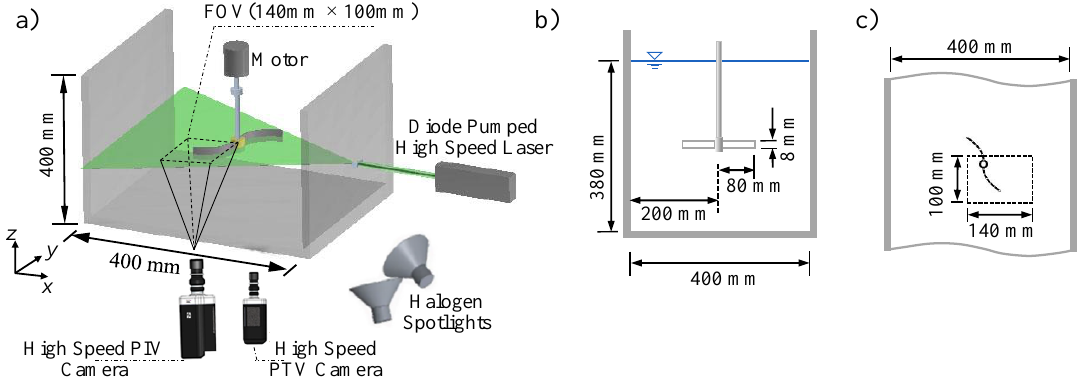
Figure 1. ( a ) Basic schematic of the experimental setup; and ( b ) side and ( c ) top views illustrating a two-plate